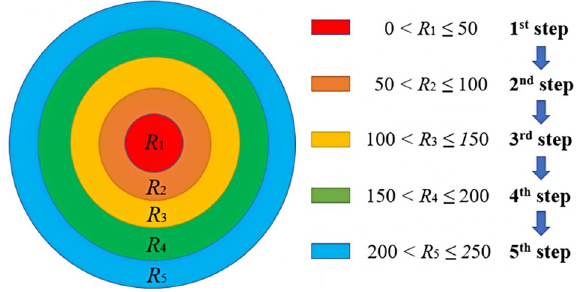
Figure 3. Tensioning arrangement